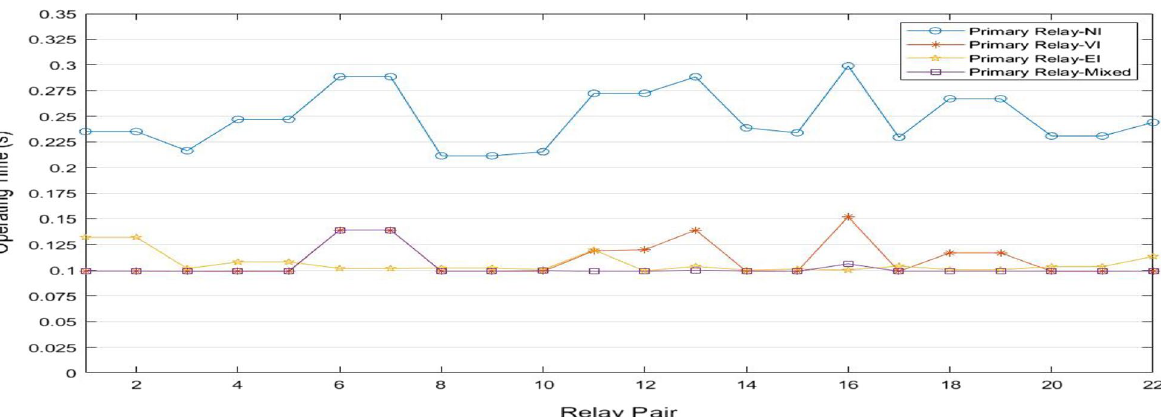
Fig. 8 Primary relay operating time having NI, VI, EI and mixed characteristics in islanded mode